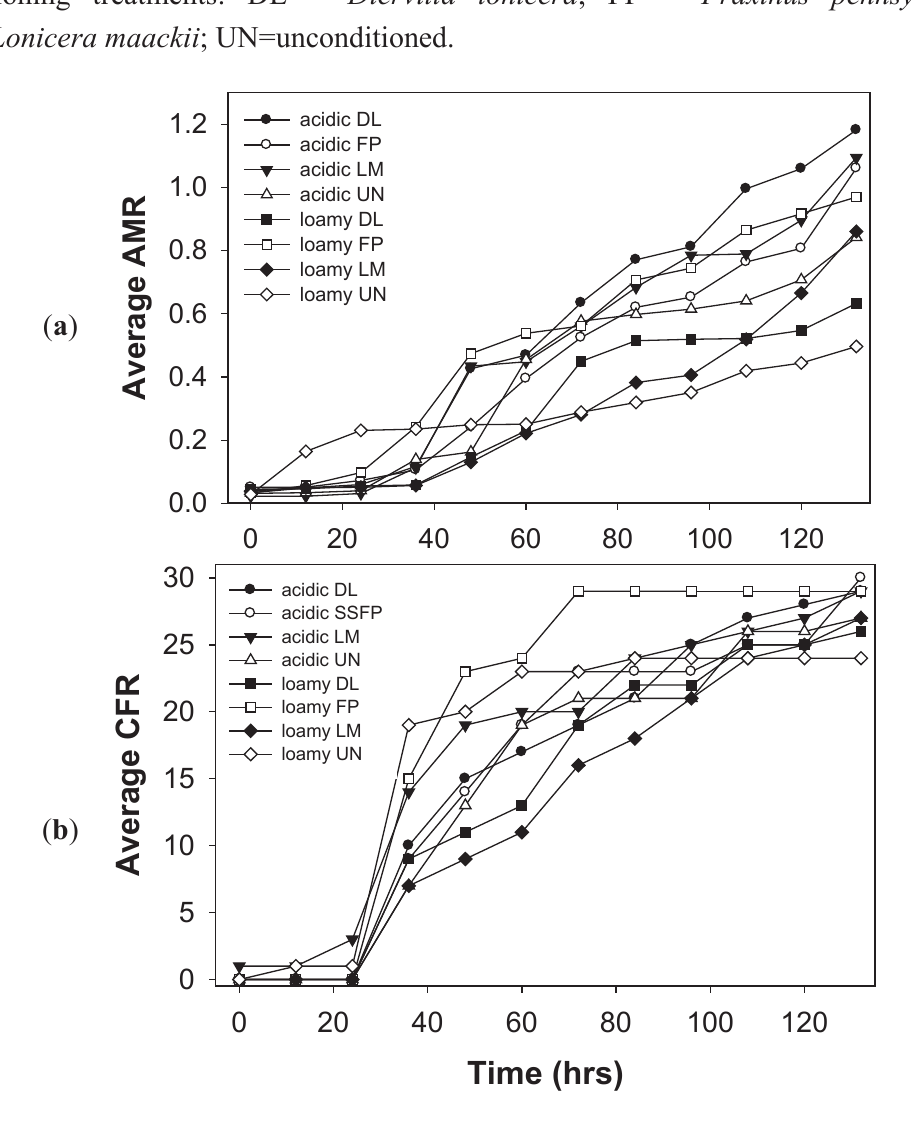
Figure 4: Average Metabolic Response (AMR) ( a ) and Community Functional Richness (CFR); ( b ) of the soil microbial community in two soil types either conditioned with growth by three different species or unconditioned. Soil type: acidic or